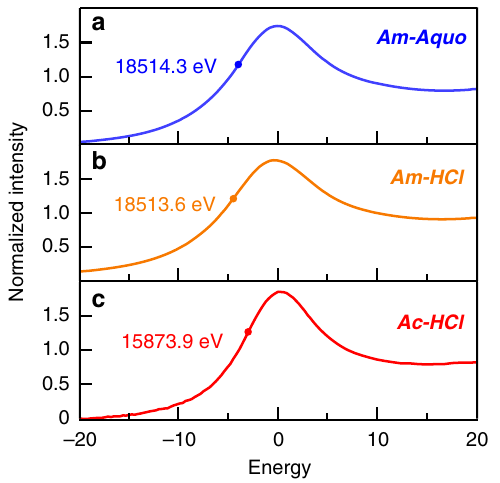
Figure 1 | Solution phase Ac III and Am III L 3 -edge XANES. ( a ) XANES spectra for Am-Aquo (0.11M HO 3 SCF 3 ) in blue trace. ( b ) XANES spectra for Am-HCl (11M HCl) in orange trace. ( c ) XANES spectra for Ac-HCl (11M HCl) in red trace. The actinium and americium spectra were calibrated in situ to RbCl pellet (15,203.81eV) and Zr foil (17,998eV)